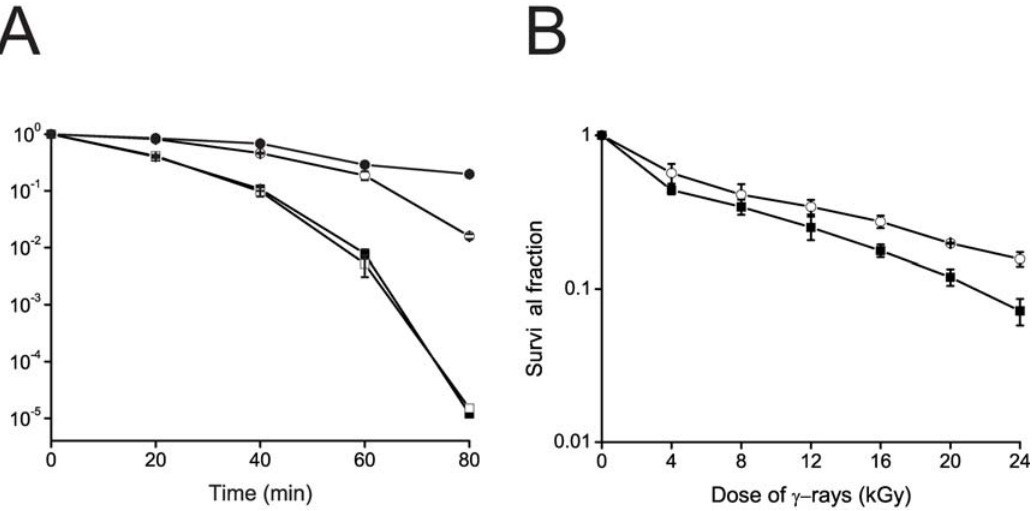
Figure 2. Survival curves of D. radiodurans strains exposed to (A) H 2 O 2 and (B) ionizing irradiation. (A) Wild-type D. radiodurans R1 ( # ) compared to MOxyR ( & ), MOxyR_wtC ( N ), and MOxyR_sdC ( % ) under 20 mM H 2 O 2 treatment at the five recovery time points (0, 20, 40, 60, and 80 min). (B) Wild-type D. radiodurans R1 ( # ) compared to MOxyR ( & ) after ionizing irradiation. Error bars represent standard deviations from four replicate experiments.